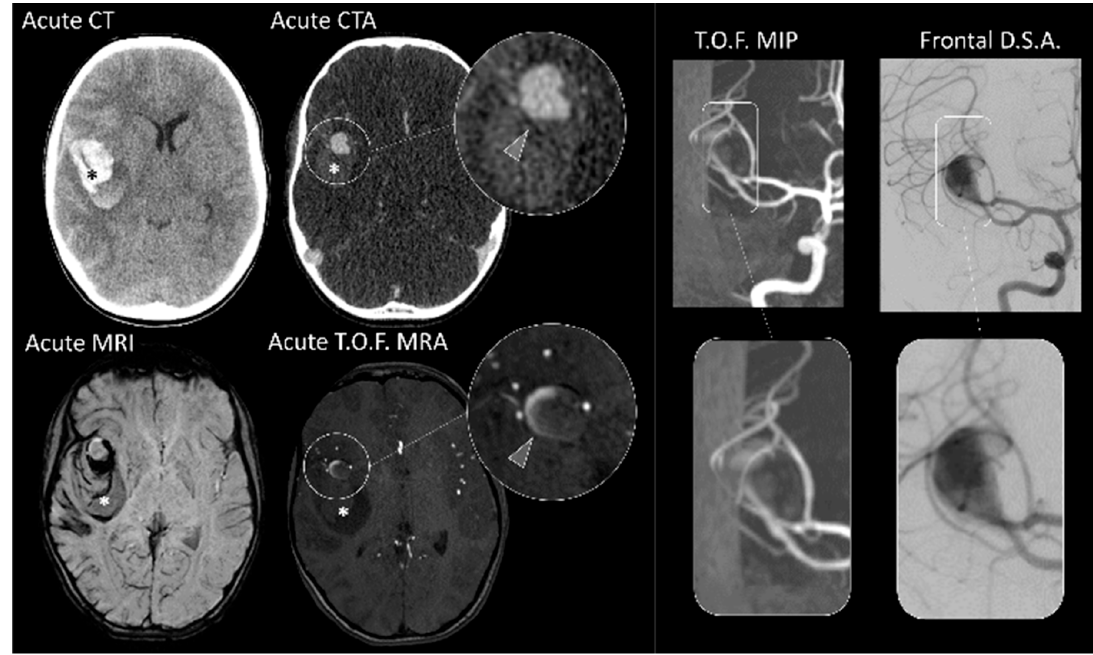
Figure 2. Vascular imaging in pediatric ICH. Admission non-contrast CT with intracerebral hemorrhage (asterisk). Corresponding CTA shows evidence of large aneurysm of the right MCA. In the MRI (bottom row and right panel)) of the same patient, TOF-angiography does not clearly show the aneurysm. The DSA clearly visualizes aneurysm morphology.